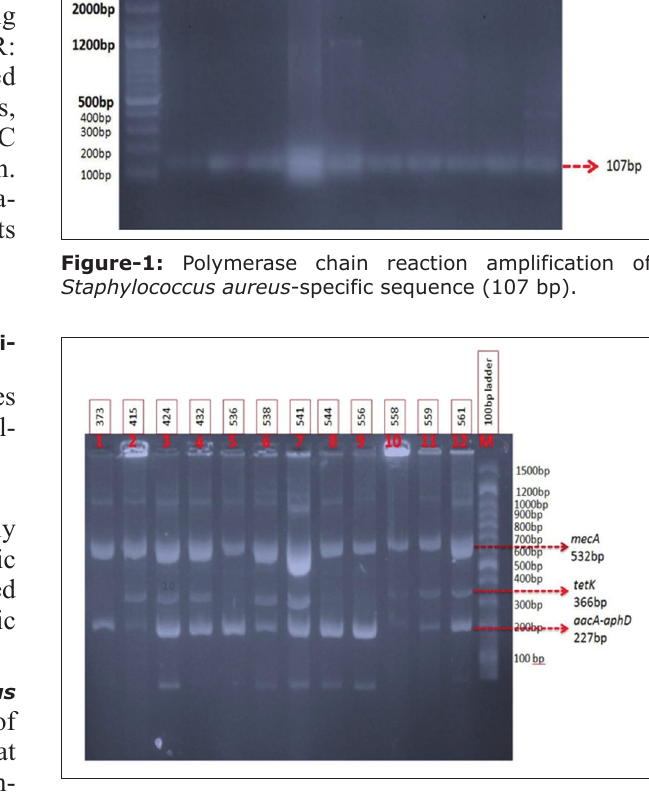
Figure-2: Genotypic characterization of antibiotic resistance pattern of different isolates of Staphylococcus aureus against methicillin, aminoglycosides, and tetracycline using multiplex polymerase chain reaction. Lane 1-12: Genotype of antibiotic resistance pattern of S. aureus isolated number 373, 415, 424, 432, 536, 538, 541, 544, 556, 558, 559, and 561, respectively, Lane M: 100 bp